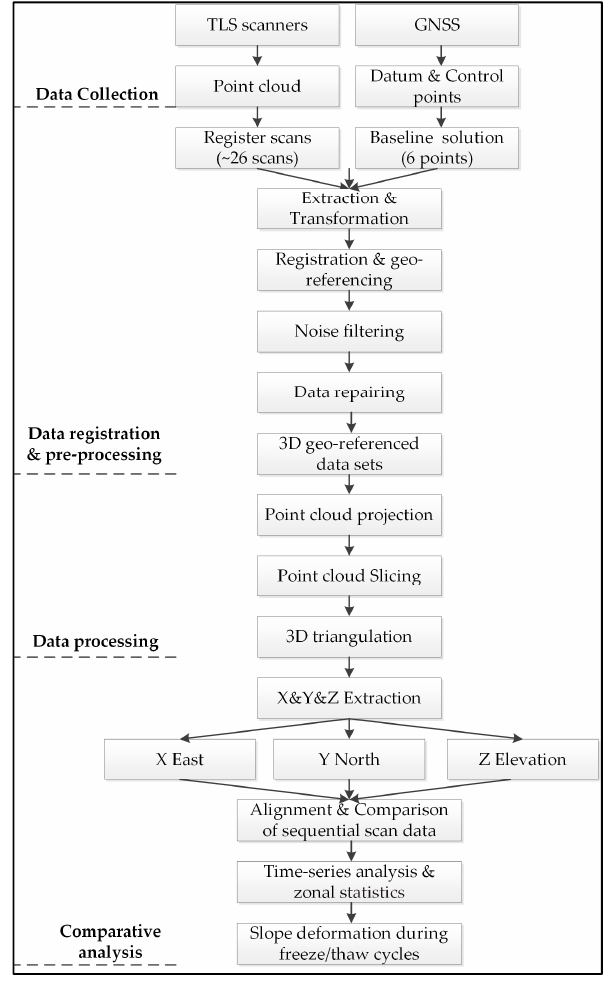
Figure 4. Workflow of data processing and analysis.